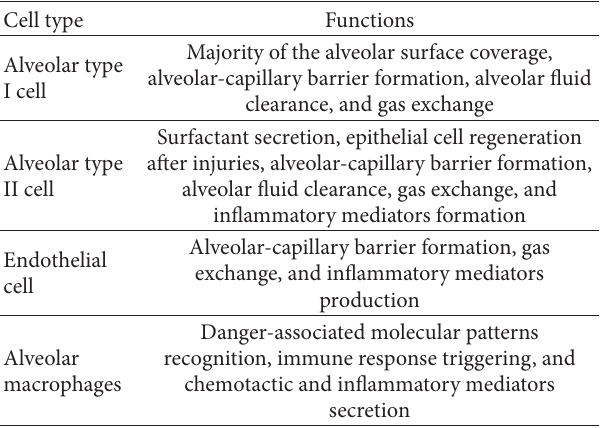
Table 2: Functions of the main lung cell types affected in ARDS- lung